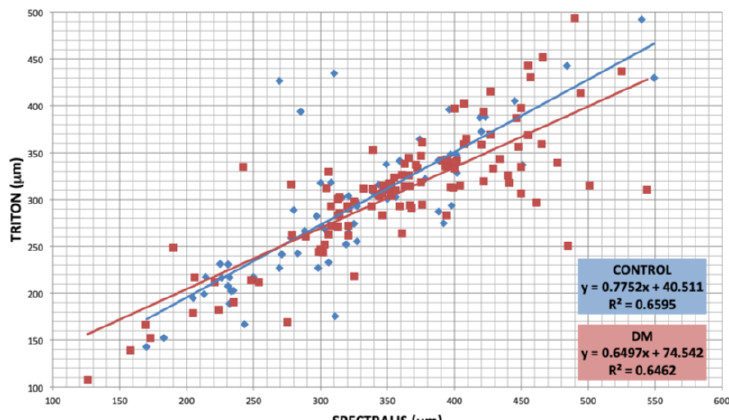
Figure 2. Agreement between subfoveal choroidal thickness (SFCT) measured with both devices in both groups. Control group (blue) showed a distribution following the equation for optical coherence tomography (SS-OCT) ( µ m) = 0.7752 × SS-OCT( µ m) + 40.511, being R 2 = 0.6595 and DM1 group (red)